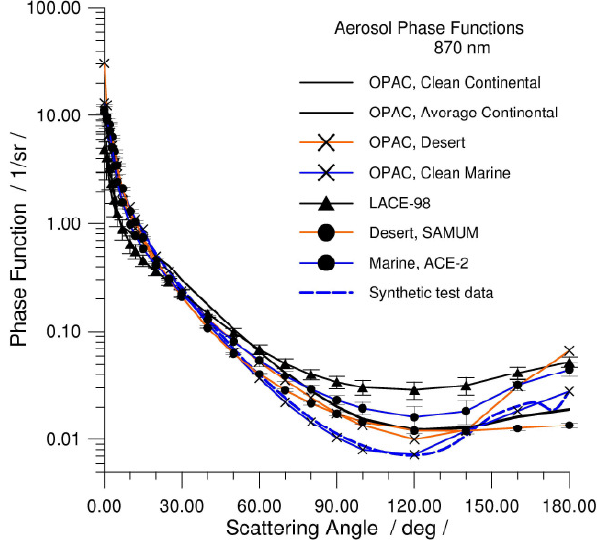
Fig. 8. Experimental phase functions of the experiments, ACE-2, LACE-98 and SAMUM in comparison with phase functions of the OPAC aerosol models, which are used for the LUT calculation. Additionally the dashed line gives the phase function for the syn- thetic data of the algorithm inter-comparison by Kokhanovsky et al. (2010).